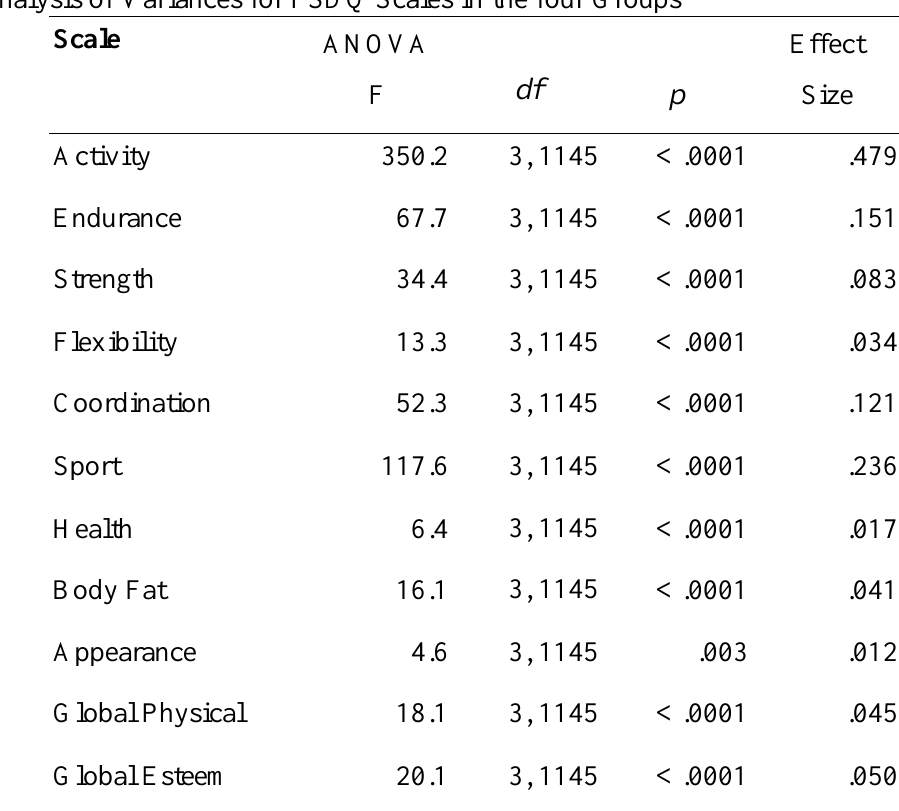
Table 3 Analysis of Variances for PSDQ Scales in the four